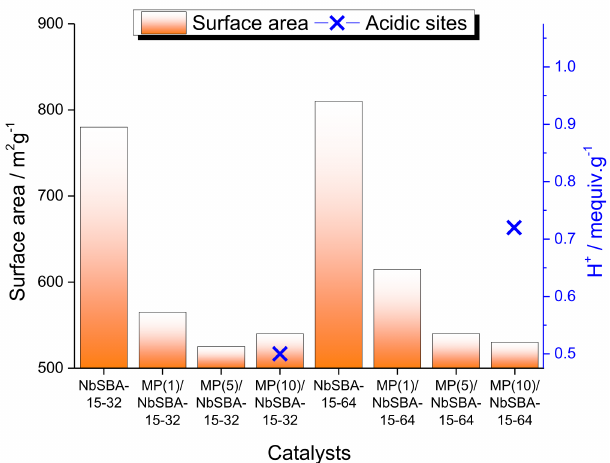
Figure 34. Variation of surface area and acidity in relation to the amount of MPTMS ((3- mercaptopropyl)trimethoxysilane), and Niobium load in the different niobiosilicate catalysts; 32 or 64 show the TEOS/Nb (tetraethyl orthosilicate/Nb) molar ratios; 1, 5, or 10 in the parentheses show the Si/MPTMS (MPTMS = (3-mercaptopropyl)trimethoxysilane) molar ratios and SBA-15 is the mesoporous molecular sieves (adapted from